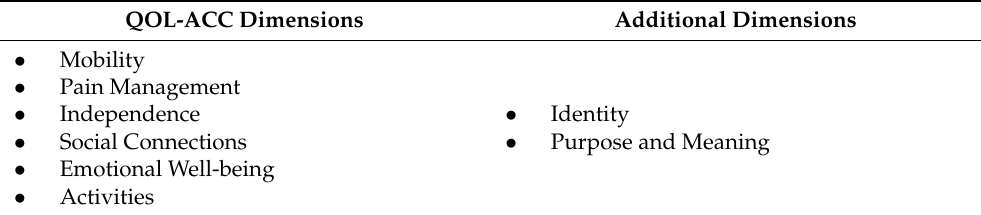
Table 2. Quality-of-Life Dimension Cards.